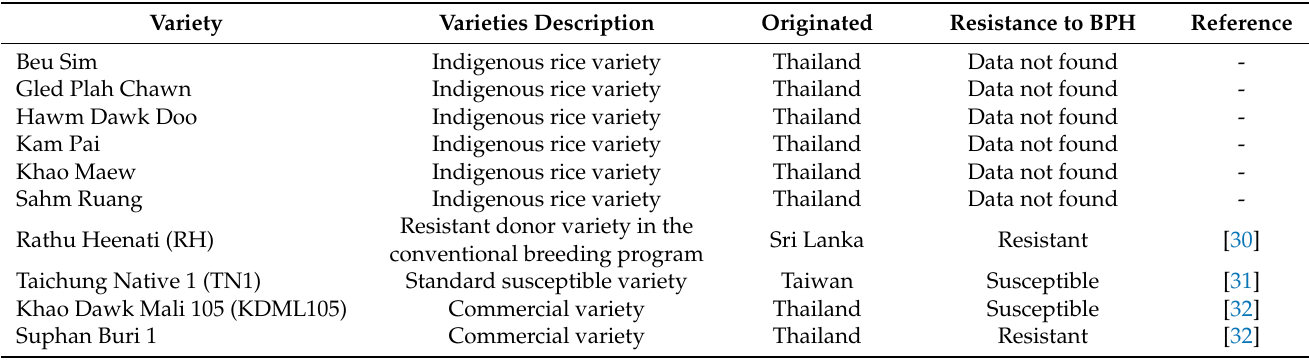
Table 1. Ten rice varieties used in the